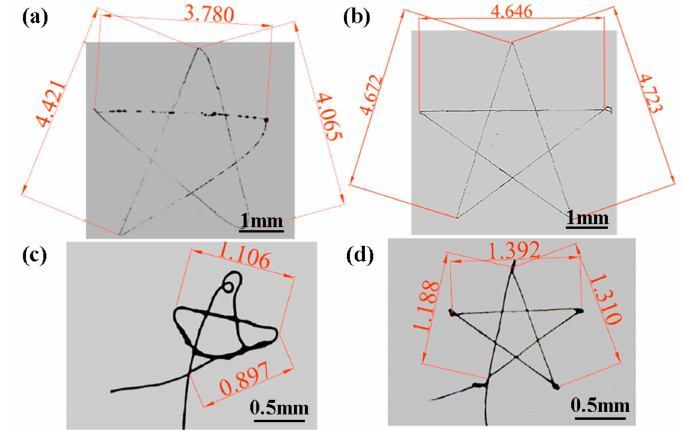
Figure 8. Pentagram patterns direct-written under various parameters. ( a ) Without assisted airflow when pentagram side length was 4.76 mm; ( b ) with assisted airflow of 25 kPa when pentagram side length was 4.76 mm; ( c ) without assisted airflow when pentagram side length was 1.33 mm; ( d ) with assisted airflow of 25 kPa when pentagram side length was 1.33 mm. The collector moving speed and the applied voltage were 10 mm/s, 2.0 kV,